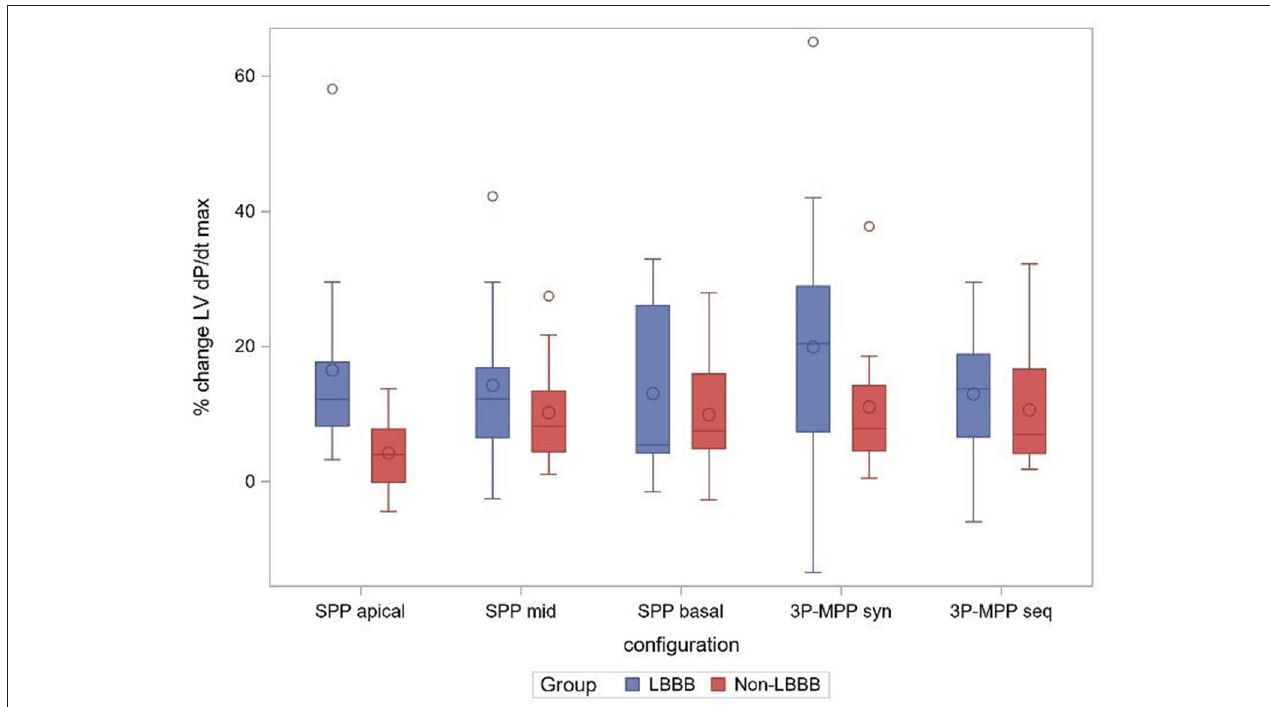
FIGURE 4 | % change 1 LV + dPdt max boxplot at best AV-delay in the subgroups LBBB and non-LBBB. SPP, RV-LV Single-point pacing and MPP, RV-LV Multi-point pacing. MPP seq , Sequential MPP; MPP syn , Synchronous (simultaneous) MPP; SPP basal,mid,apical , SPP from base, mid, apical LV electrode. Solid line depicts the median value, and boxes are 25th and 75th percentile. Whiskers represent the most extreme data point within 1.5x interquartile range from the boxes. Diamonds represent mean value, and dots are